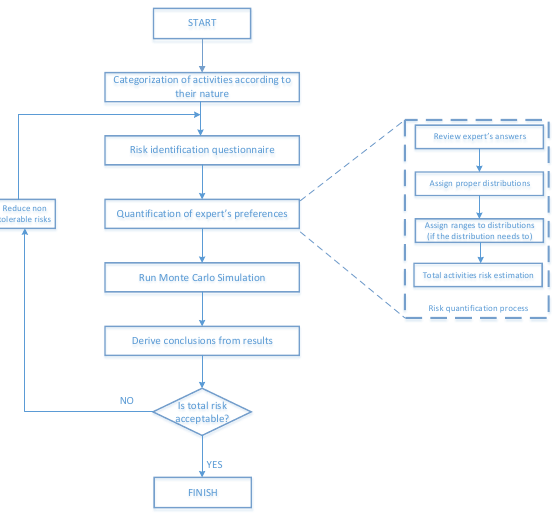
Figure 1. The flowchart of the proposed approach for risk analysis.